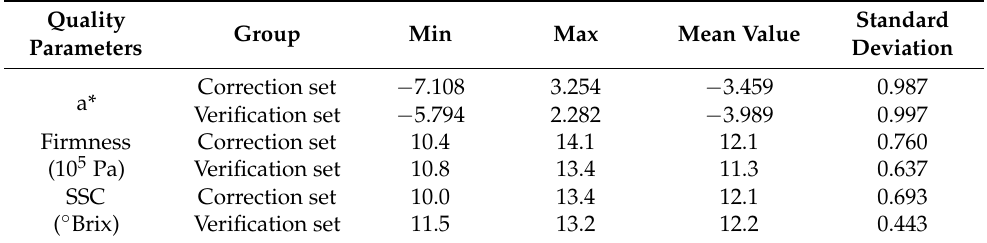
Table 2. Statistics of the quality parameters in the calibration and validation sets.